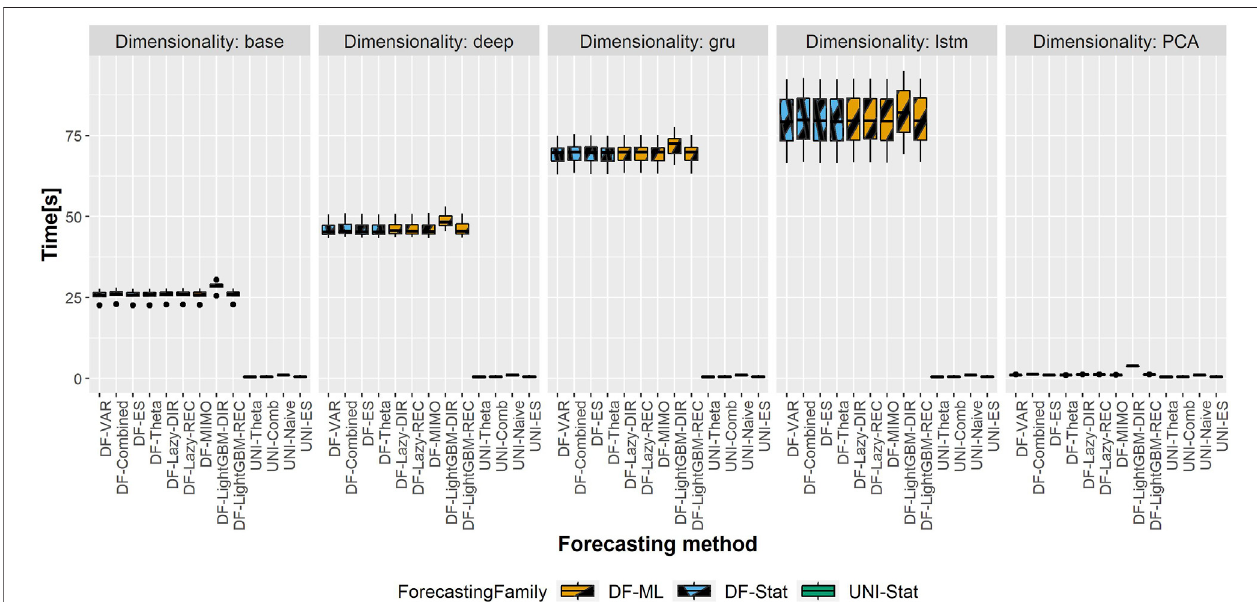
FIGURE7| Traf fi c — Boxplots representing thedistributionofthe computationaltime (in s) acrossthe different rollingwindow forthe longest horizon ( H (cid:1) 24). Each column in the grid represents a different factor estimation technique.